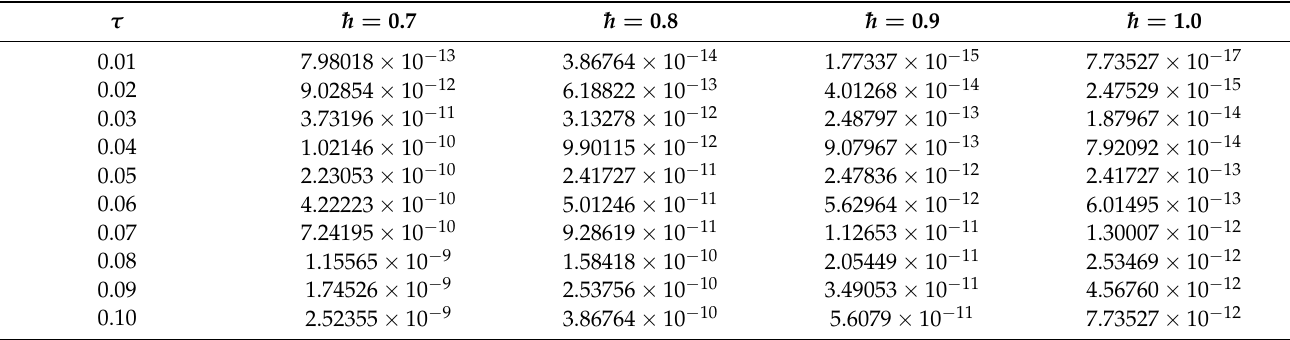
Table 2. The | Ω 5 ( α , τ ) − Ω 4 ( α , τ ) | of Problem 1 at varying values of ¯ h at α = 0.002 determined by the ARPSM at plausible locations in the range τ ∈ [ 0, 0.10 ]